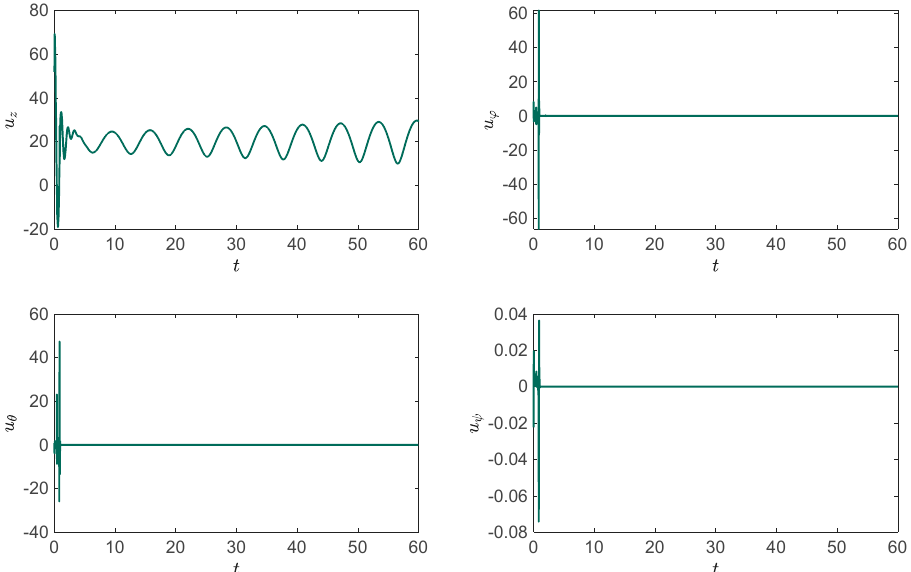
Figure 6. Control signals obtained based on the proposed control technique.